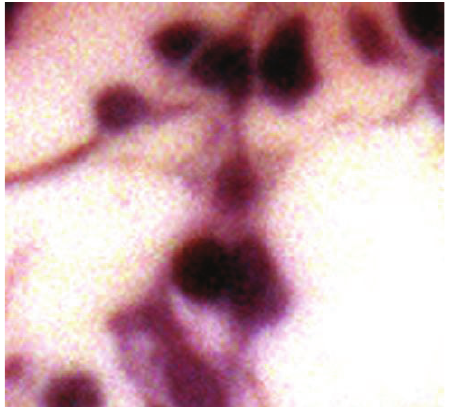
Figure 1: Normal cells control growth by programmed death known as apoptosis. Cancer cells conversely build genetic muta- tions that can result in uncontrolled growth after at least the fourth mutation. (With permission from the National Institutes of Health/Department of Health and Human Services).